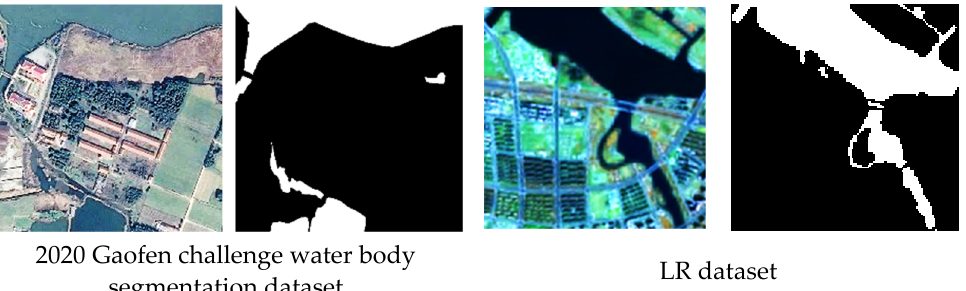
Figure 5. Qualitative segmentation examples from the 2020 Gaofen challenge water body segmen- tation dataset ( left two ) and the LR dataset ( right two ).